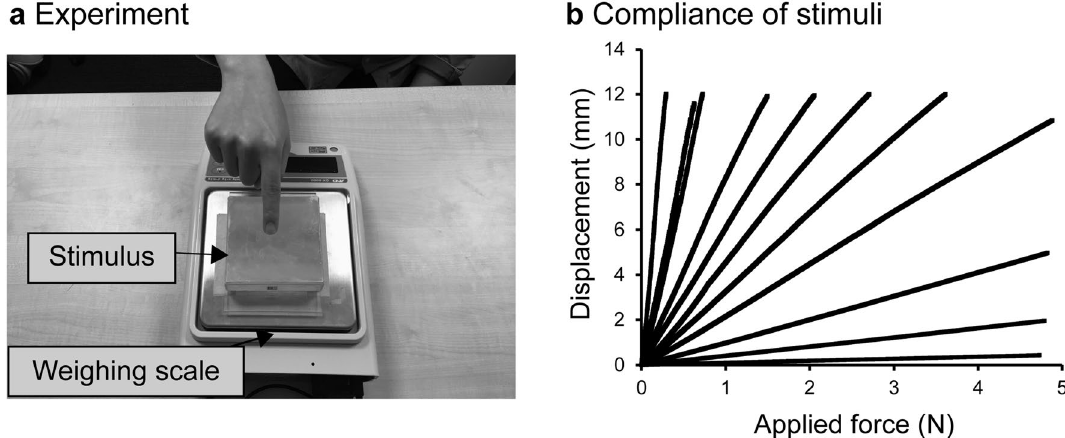
Figure 1. Stimuli and stimulus presentation (Experiment 1). ( a ) Task Two groups of healthy volunteers (24 for each) participated in the experiment. The participants in both groups used their right index fingers to touch the same location (e.g., center) of each stimulus on the scale. After touching the surface up to three times, half of the participants were asked to estimate pleasantness (pleasantness-instruction group), whereas the other half were asked to estimate softness (softness-instruction group). Data were normalized and log transformed (base 10). The scale transferred the applied vertical force data to the computer (not shown). ( b ) Stimulus and compliance All stimuli were made of urethane rubbers of varying compliance. The relationship between applied force and displacement was measured for each stimulus with a compression tester. Compliance of each stimulus was defined as the slope of the linear function fitted to displacement as a function of applied